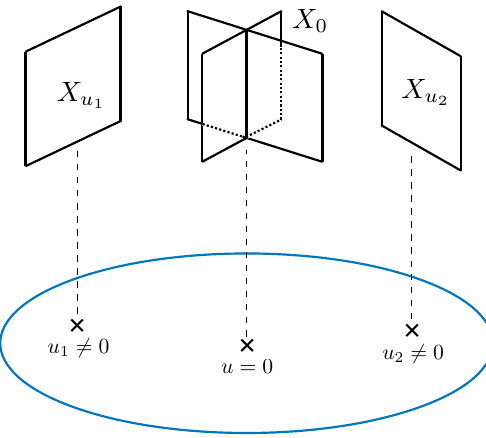
Figure 1 . Semi-stable degeneration of K3